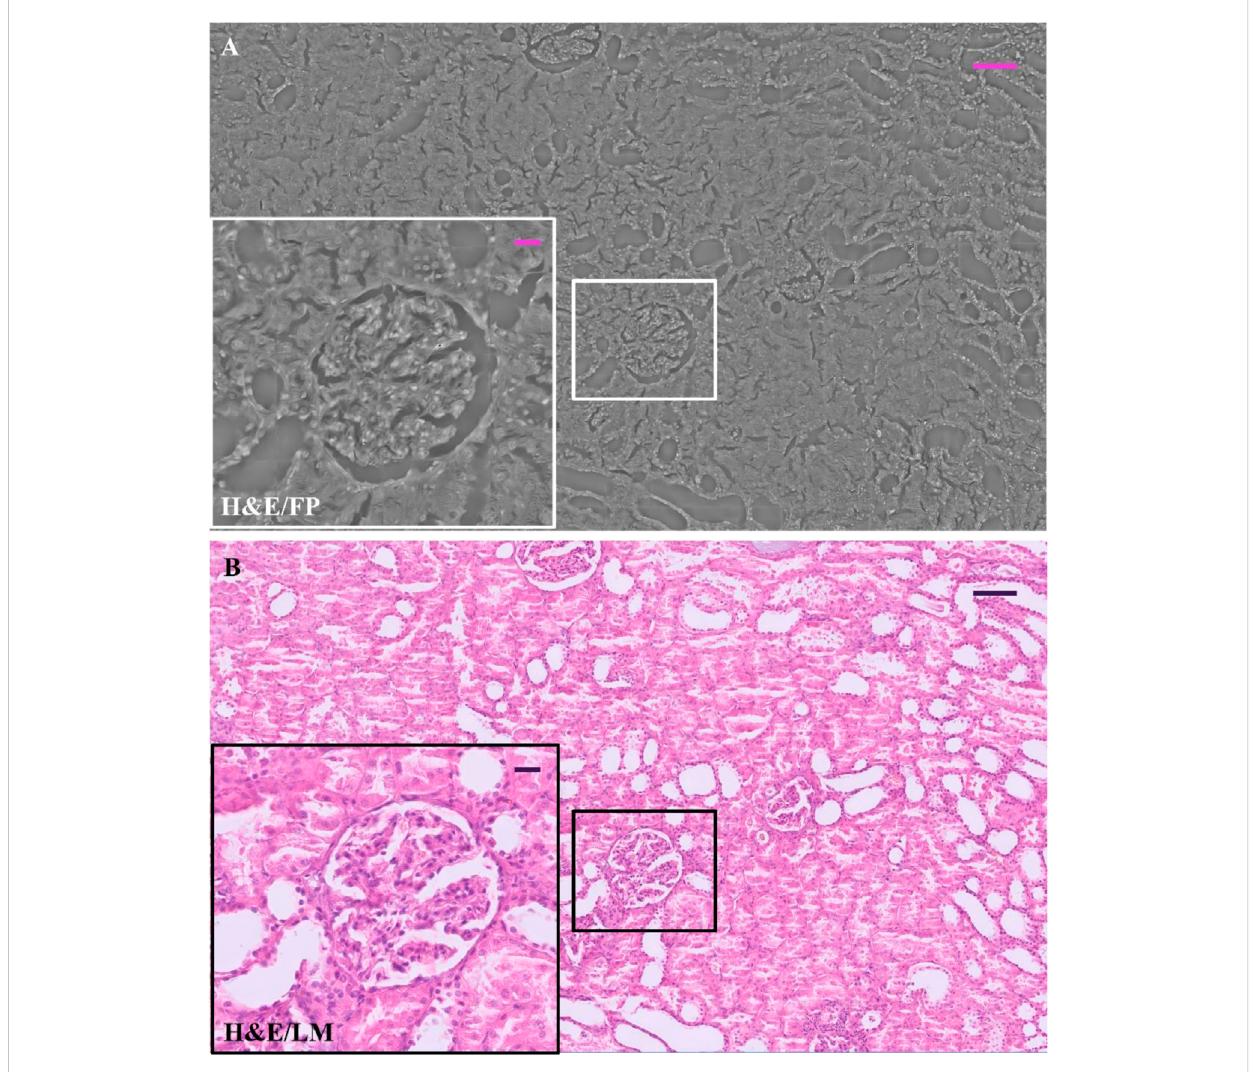
FIGURE 1 H&E-stained renal tissue: (A) Whole renal tissue FP image; the inset (white box) zooms glomerulus captured by FP; (B) whole renal tissue LM image; the inset (black box) zooms glomerulus captured by LM. The scale bar in (A) and (B) is 105 μ m, while the scale bar in the respective insets is 25